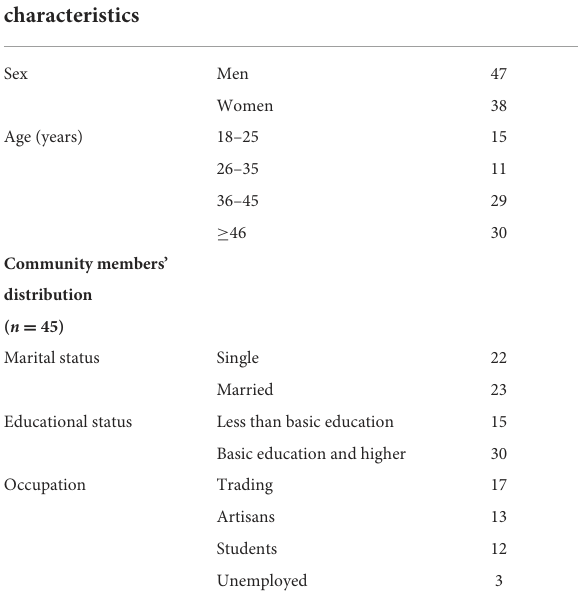
TABLE 2 Age and sex distribution of the study